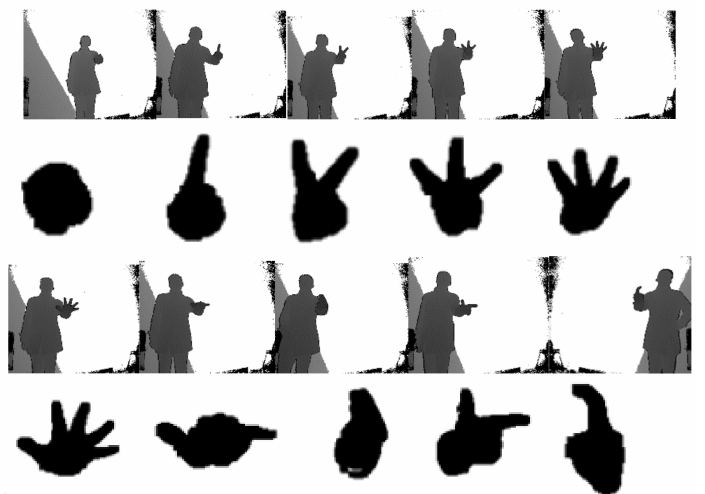
Figure 6. One group of depth images and segmented hand region: the depth images given in the first and third rows with corresponding hand in the second and fourth